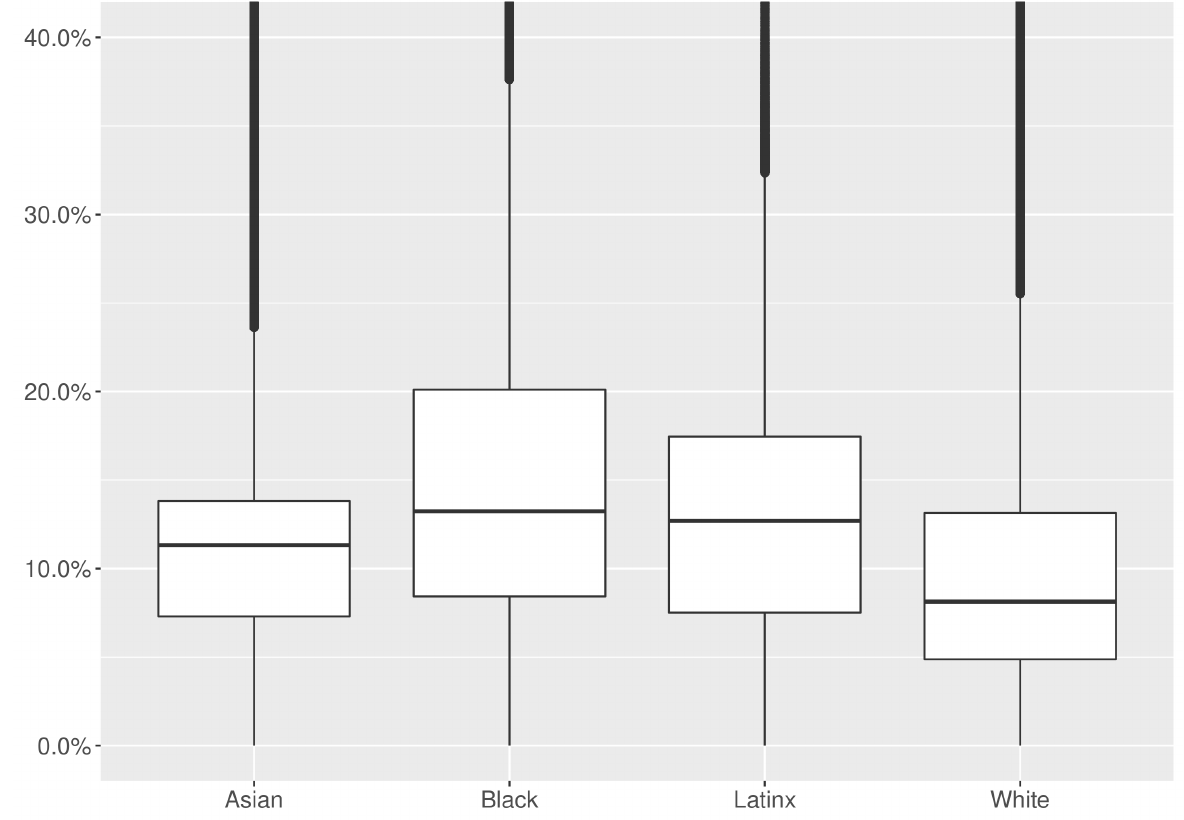
Figure 4: Distributions of serial eviction filing rates by race/ethnicity. Note: Data are presented as box and whisker plots, displaying distributions through five statistics: the median (the horizontal line within the white box for each state), the 25th and 75th percentiles (which form, respectively, the lower and upper bounds of each box), and two whiskers. Whiskers extend no more than 1.5 times the interquartile range (the distance between the first and third quartiles). Rates beyond the range of the whiskers are considered outliers and are plotted as individual